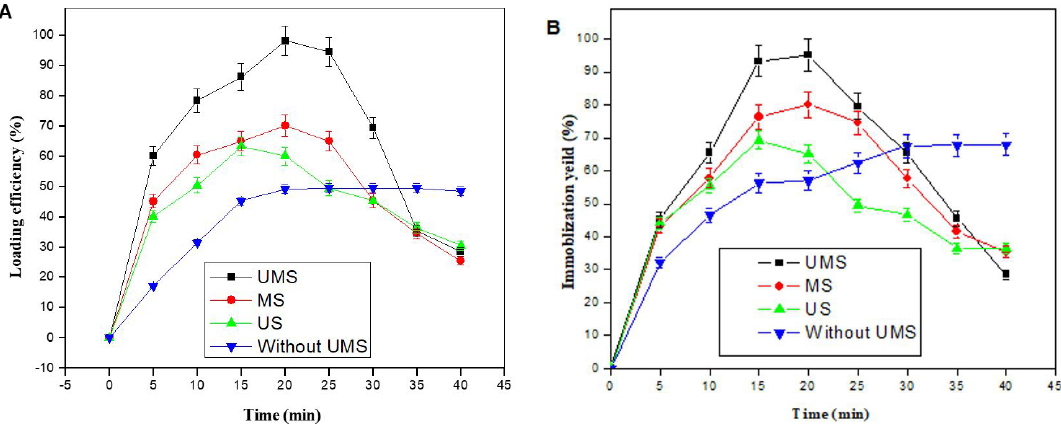
Figure 2. Effects of UMS treatment duration on the ( A ) LE and ( B ) IY of the immobilized enzyme prepared with and without UMS treatment.